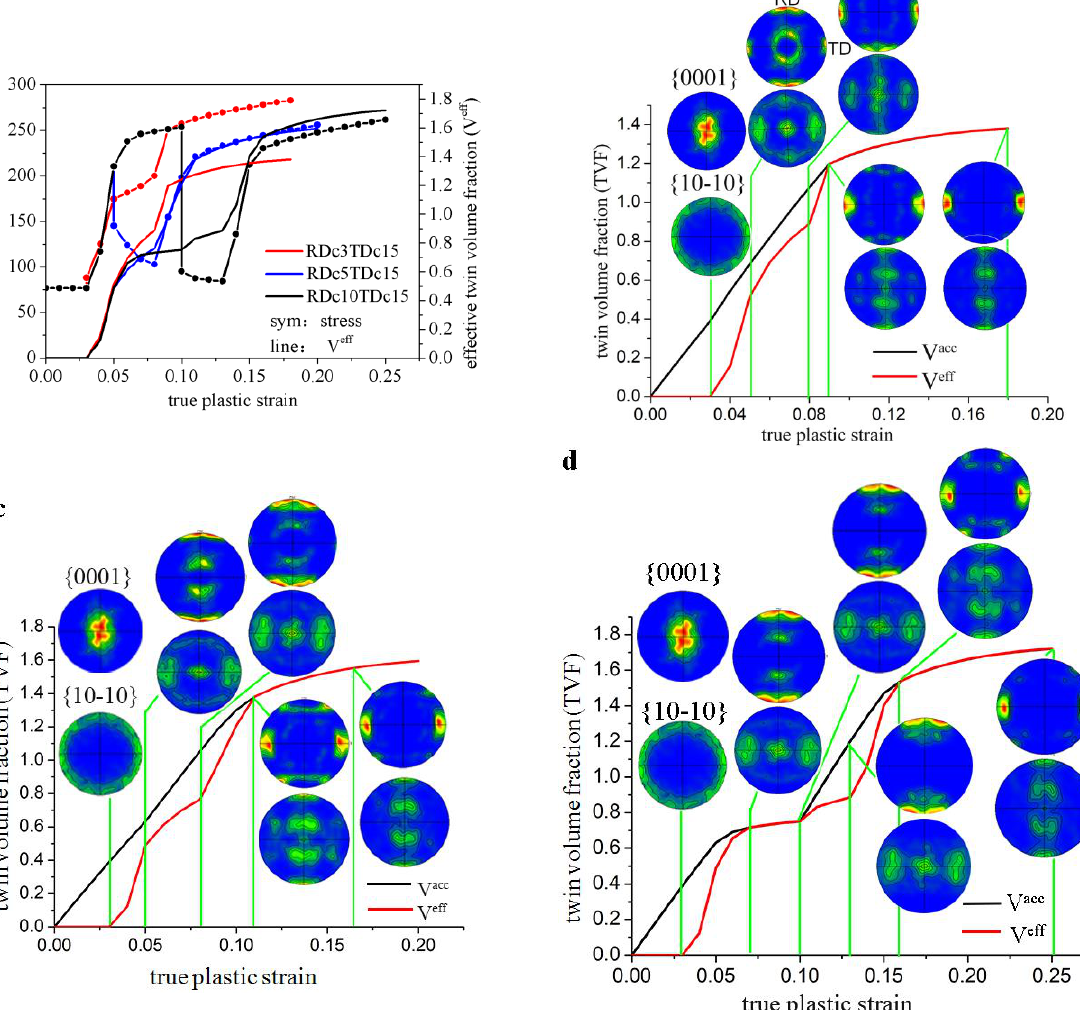
Fig. 4. (a) Flow stress (symbols) and effective twin volume fraction (line), texture development and twin volume fraction (accumulated and effective) vs strain corresponding to (b) RDC3TDC15, (c) RDC5TDC15, and (d)